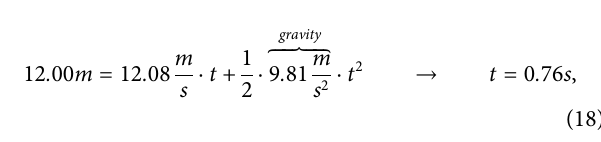
Frontiers in Built Environment |